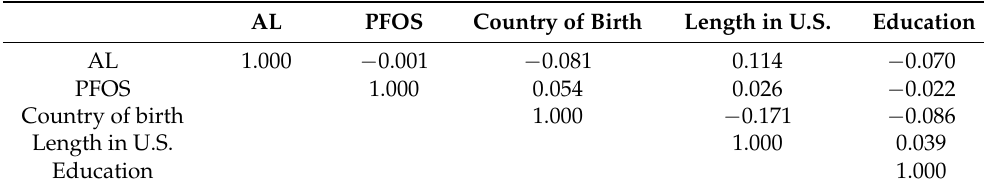
Table 5. Correlation between AL, PFOS (ng/mL), Country of Birth, Length of Time in the U.S., and Education Level. AL PFOS Country of Birth Length in U.S. Education 1.000